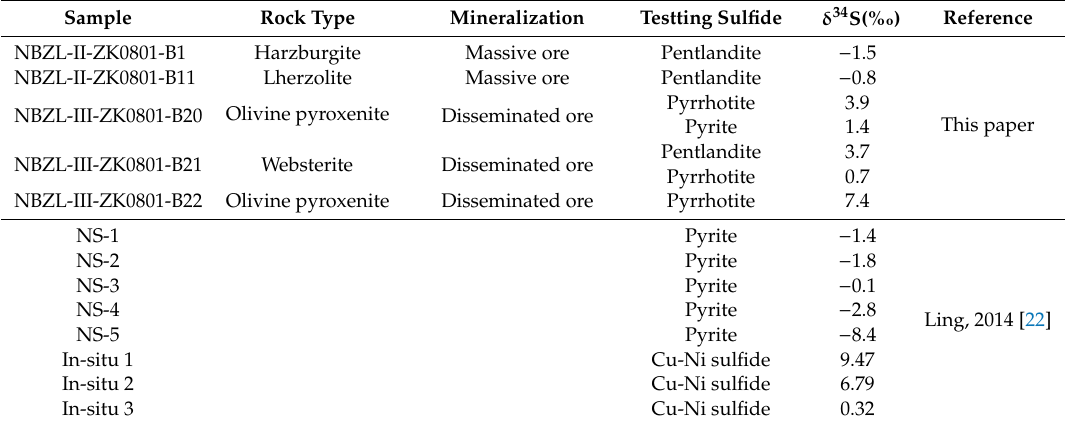
Table 2. The sulfur isotopes of sulfides from the Niubiziliang mafic-ultramafic complex.